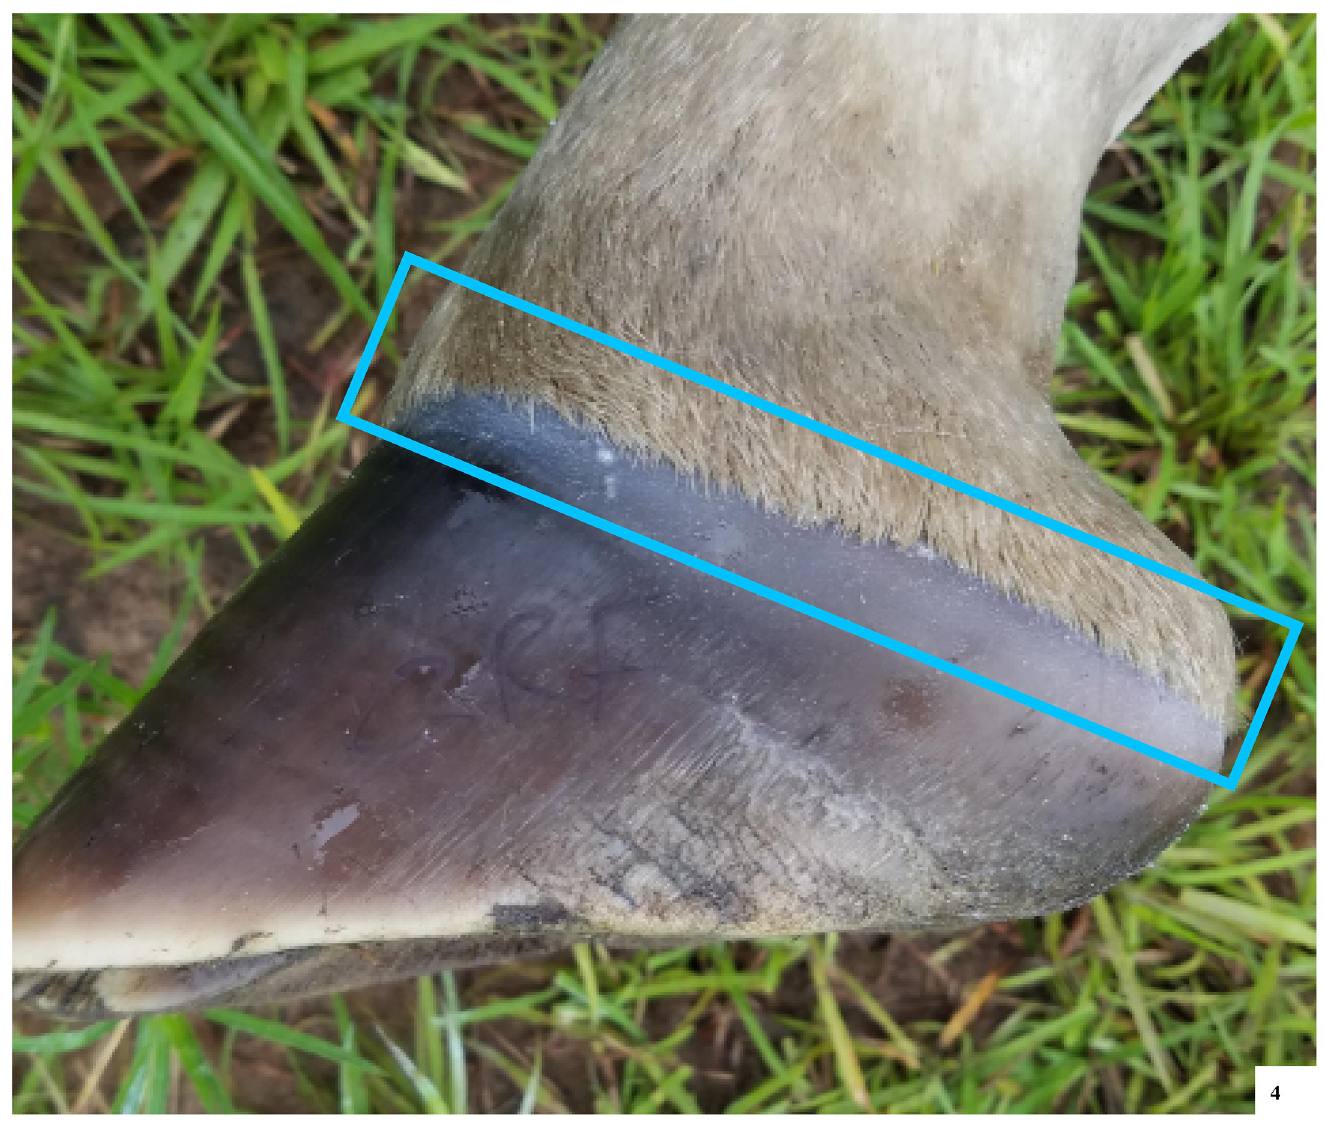
Fig 4. Lateral view of a giraffe front foot, showing a relatively straight coronary